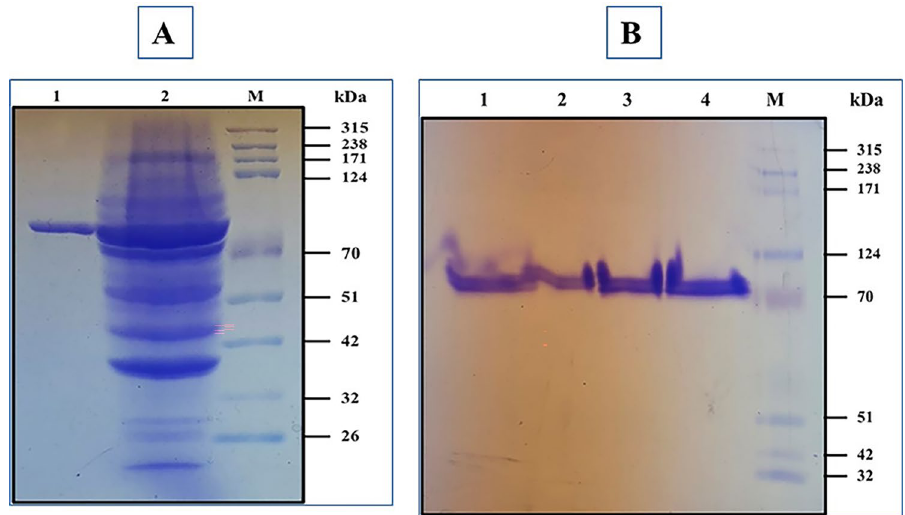
Fig. 1 A) 12% SDS-PAGE showing purification steps of Pull_Met using Nickel -affinity agarose chromatography. Lane M: Protein ladder. Lane 1: purified Pull_Met after Nickel -affinity agarose chromatography column. Lane 2: crude cell lysate of induced recombinant E. coli BL21 (DE3) Rosetta cells. B) 10% native-PAGE showing the multimerization status of Pull_Met. Lane M: Protein ladder. Lanes (1–4): Pull_Met purified to homogeneity using nickel affinity chromatography